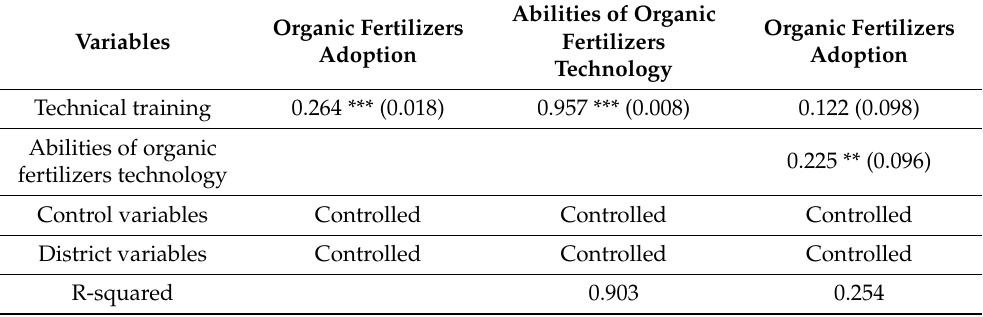
Table 6. The results of the mediating effects of farmers’ abilities with organic fertilizers